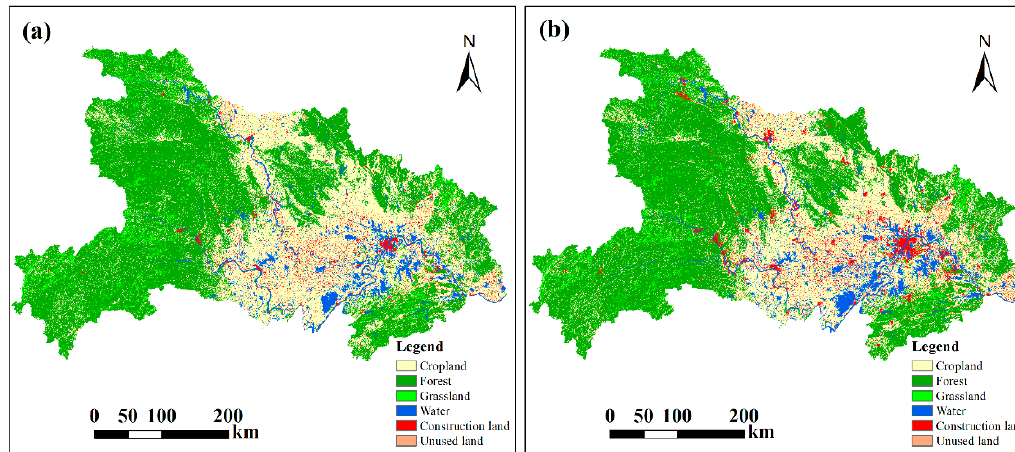
Figure 2. Land use of Hubei Province in 2000 ( a ) and 2018 ( b ). Table 1. Statistics of the areas (km 2 ) and ratios (%) of the land use types in Hubei Province in 2000 and 2018.